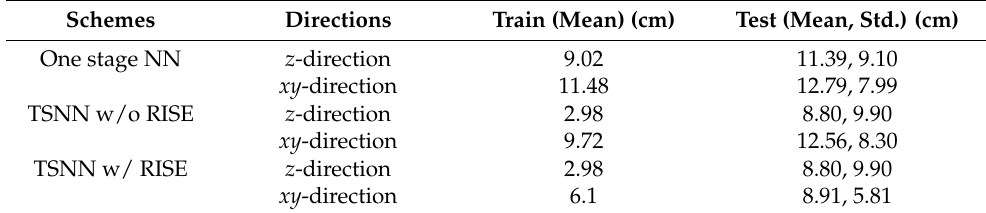
Table 2. Mean error and standard deviation of different schemes.